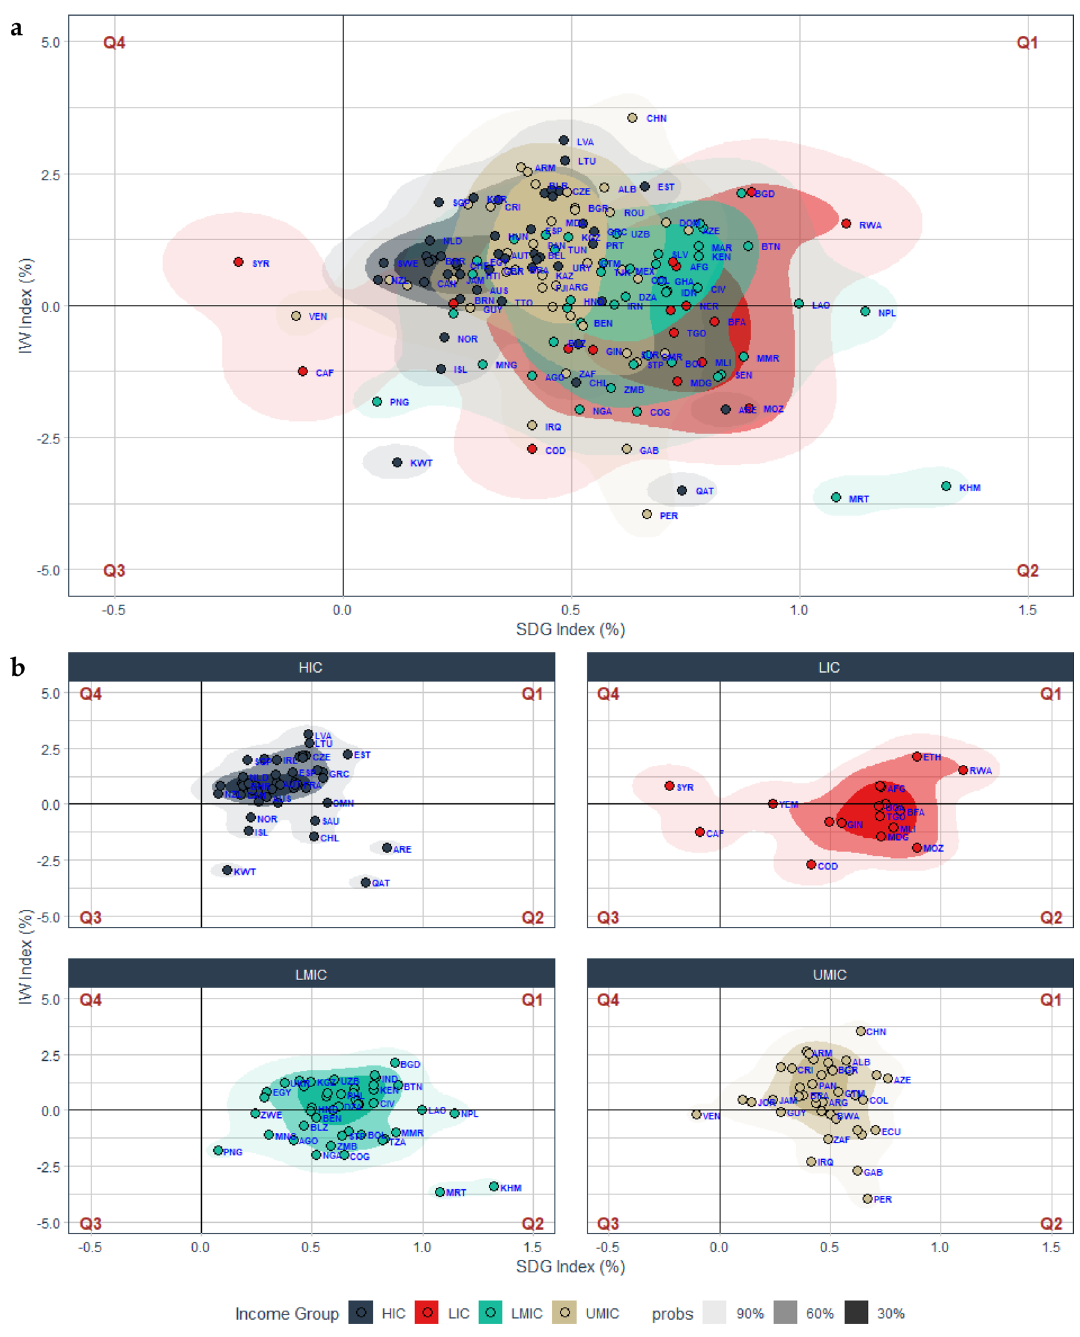
Figure 1. Correlation between the SDG Index and the IW Index. Visualization of annual average growth rate in SDG Index score and per capita IW Index between 2000 and 2019 using kernel density estimator (KDE). Plot generated with R package ggdensity 44 . Each color indicates a different country’s income group; black for high- income countries (HIC), brown for upper-middle-income countries (UMIC), green for lower-middle-income countries (LMIC), and red for low-income countries (LIC). The gradient of the colors indicates the probability based on KDE; light colors indicate a higher probability while darker colors indicate a lower probability. Q1, Q2, Q3, and Q4 represent quadrants in the plot which portray how well a particular country follows the sustainable development path. Q1 depicts the most sustainable path since the positive growth in the SDG Index score was followed by positive growth in the per capita IW Index, while Q3 represents the most unsustainable path since both the SDG Index score and the per capita IW Index were decreasing. ( a ) Progress in SDG Index score and per capita IW Index growth for 147 countries. ( b ) The progress in SDG Index score and the growth in per capita IW Index by income